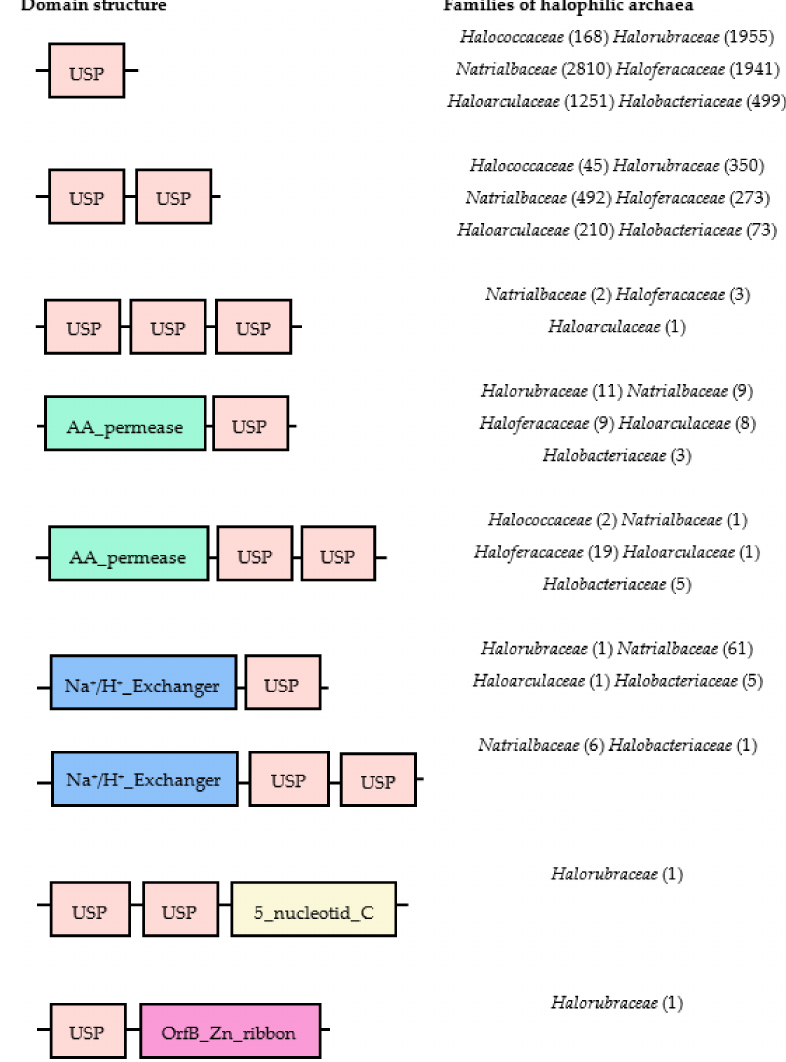
Figure 1. Domain structures of halophilic archaeal Universal Stress Proteins (USPs). The diverse domains were obtained from the UniProt database (https: // www.uniprot.org / ). The numbers in parenthesis indicate the numbers of USPs having this specific structure in each haloarchaea family. Each type of domain is in di ff erent color-boxes. AA: amino